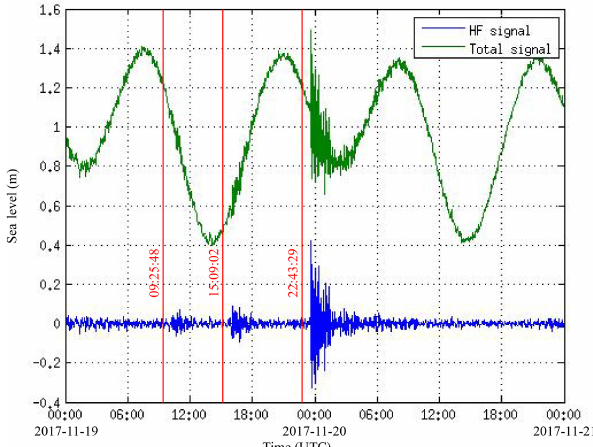
Figure 8. The triplet of tsunamis of 19 November 2017 recorded by the Ouinné tide gauge. The blue graph shows the filtered signal without the tide (the tide signal is visible on the green graph). The red lines show the times of the three different earthquakes.